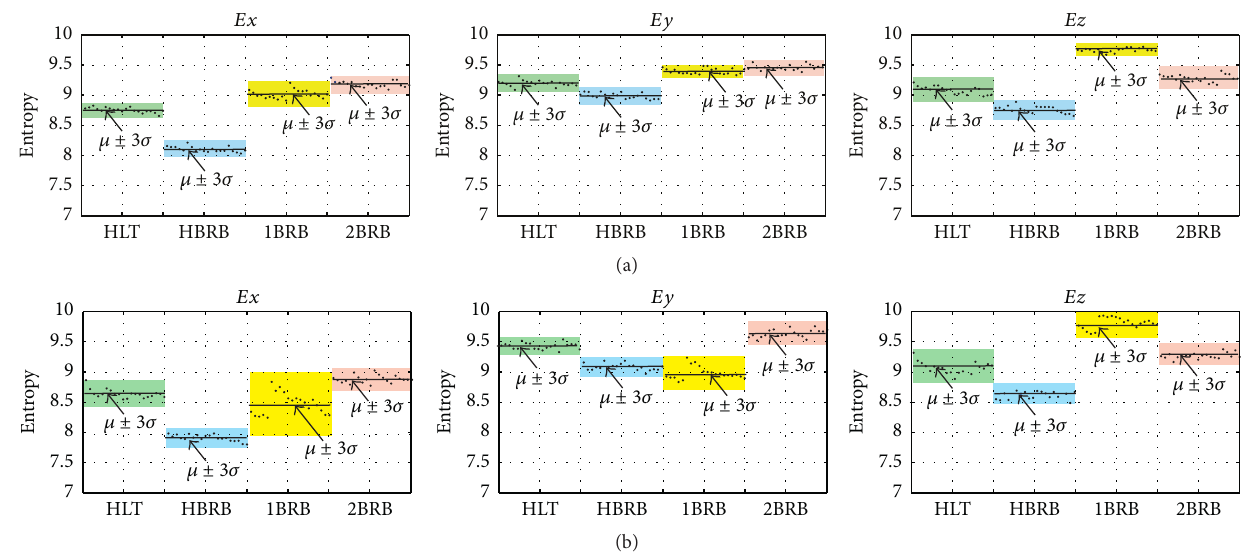
Figure 5: Entropy values for (a) startup transient tests and (b) steady state